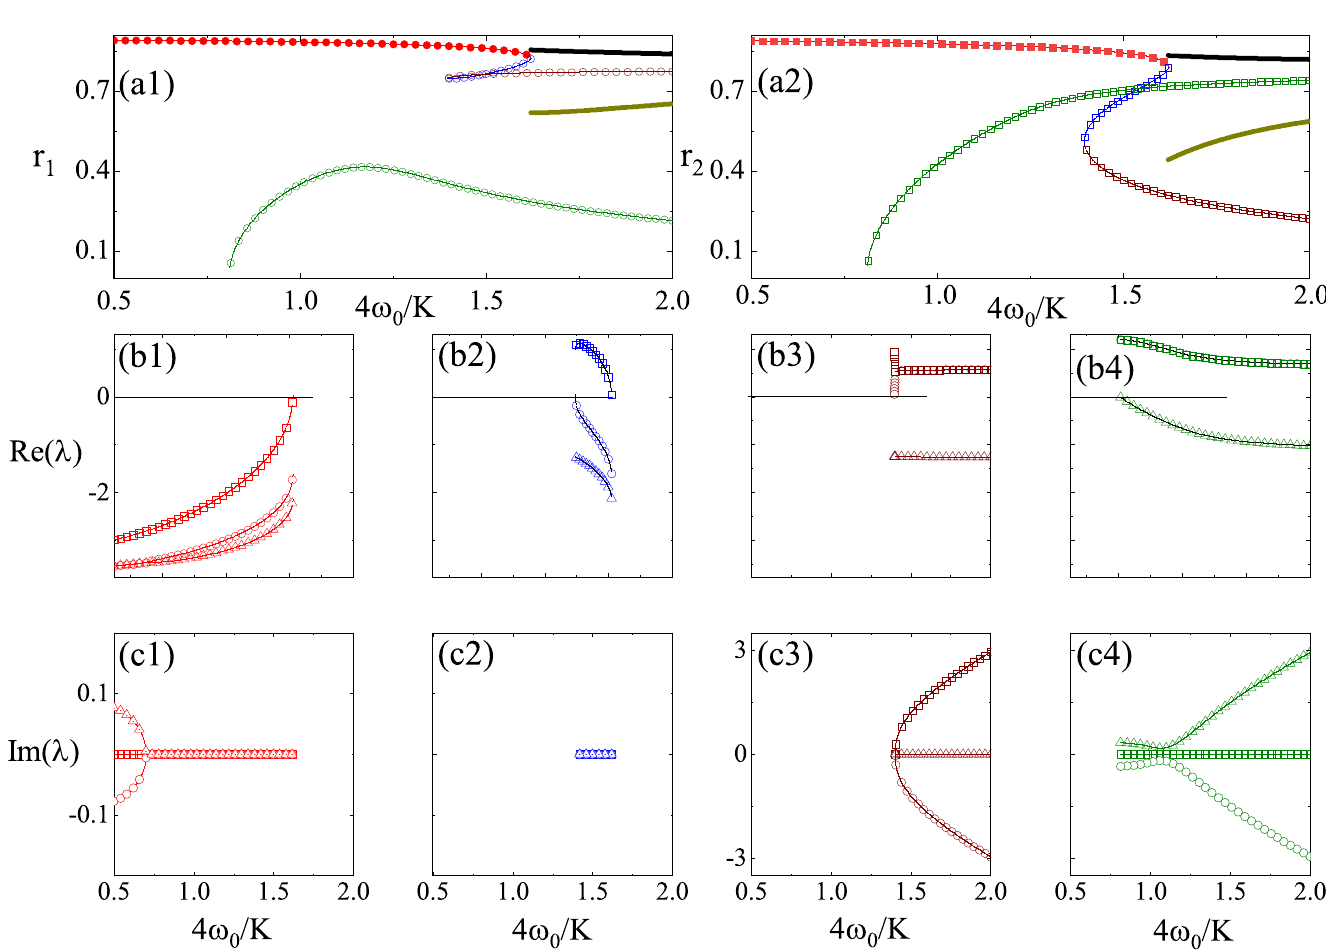
Fig 1. (Color online) Bifurcation diagrams of r 1 , r 2 and λ against ω 0 = 4 ω 0 / K . K = 4, β = 0.1, and Δ 0 = 4 Δ / K = 0.4. Solid (open) data points represent stable (unstable) states. In top panels, red, blue, wine, and dark green symbols are for partial synchronous states FP ð 1 Þ lines represent the maximum and minimum values of r 1 and r 2 for stable standing wave synchronous states. In middle and bottom panels, from left to right, real and imaginary parts of the eigenvalues λ for partial synchronous states from FP ð 1 Þ respectively.